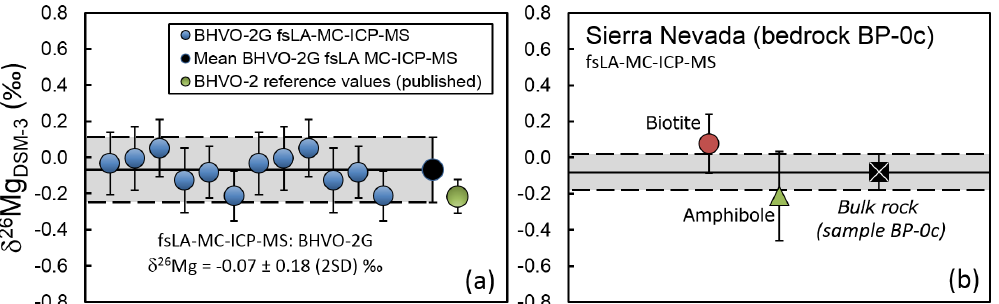
Figure 1. Mg isotopic composition measured by fsLA-MC-ICP-MS. (a) Repeat measurements of BHVO-2G. Solid black circle and solid line represent the mean value of all BHVO-2G measurements with the 2SD range represented by dashed lines. Published literature data (Dai et al., 2016) is shown for comparison. (b) Biotite and amphibole of sample BP-0c measured by fsLA-MC-ICP-MS. Bulk rock was measured by solution MC-ICP-MS.